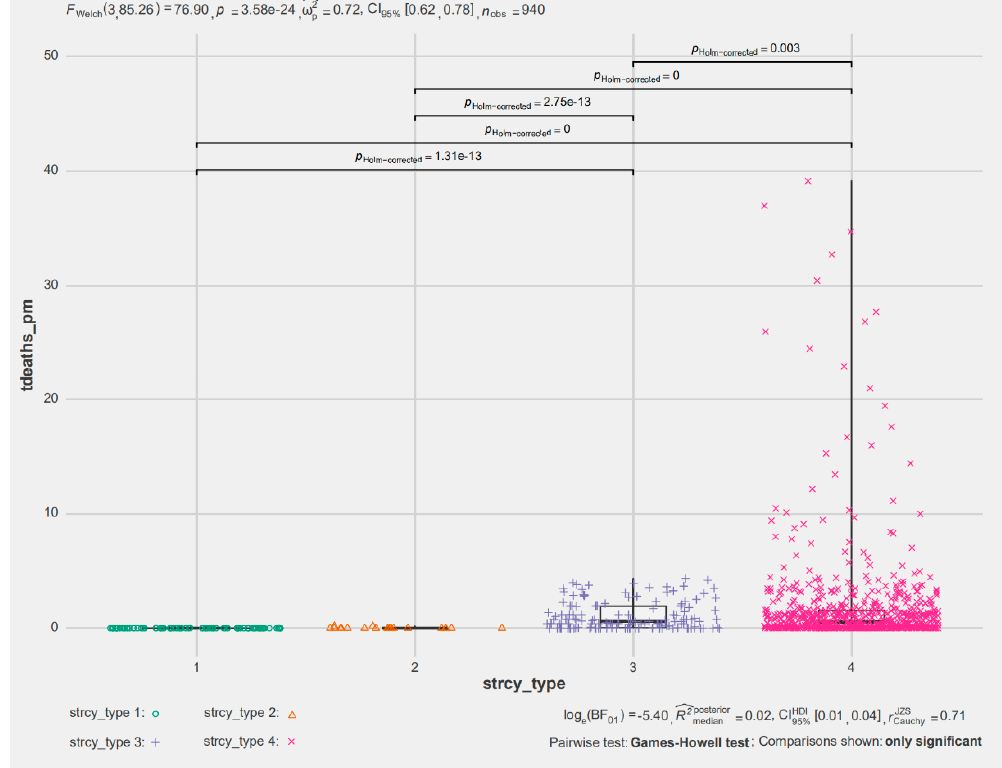
Figure 3. Games–Howell test of deaths per million people under different policy control levels.